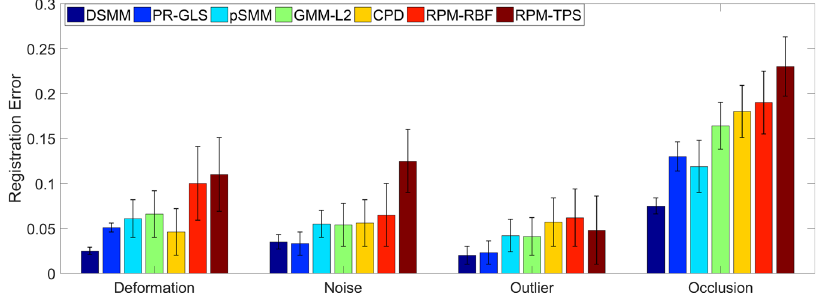
Figure 5. Comparison of DSMM with PR-GLS, SMM, GMM-L2, CPD, RPM-RBF and RPM-TPS on Chinese characters with deformation, noise outliers and occlusion. The y axis of error bar indicates the statistical registration error, where a small value reveals a good performance.